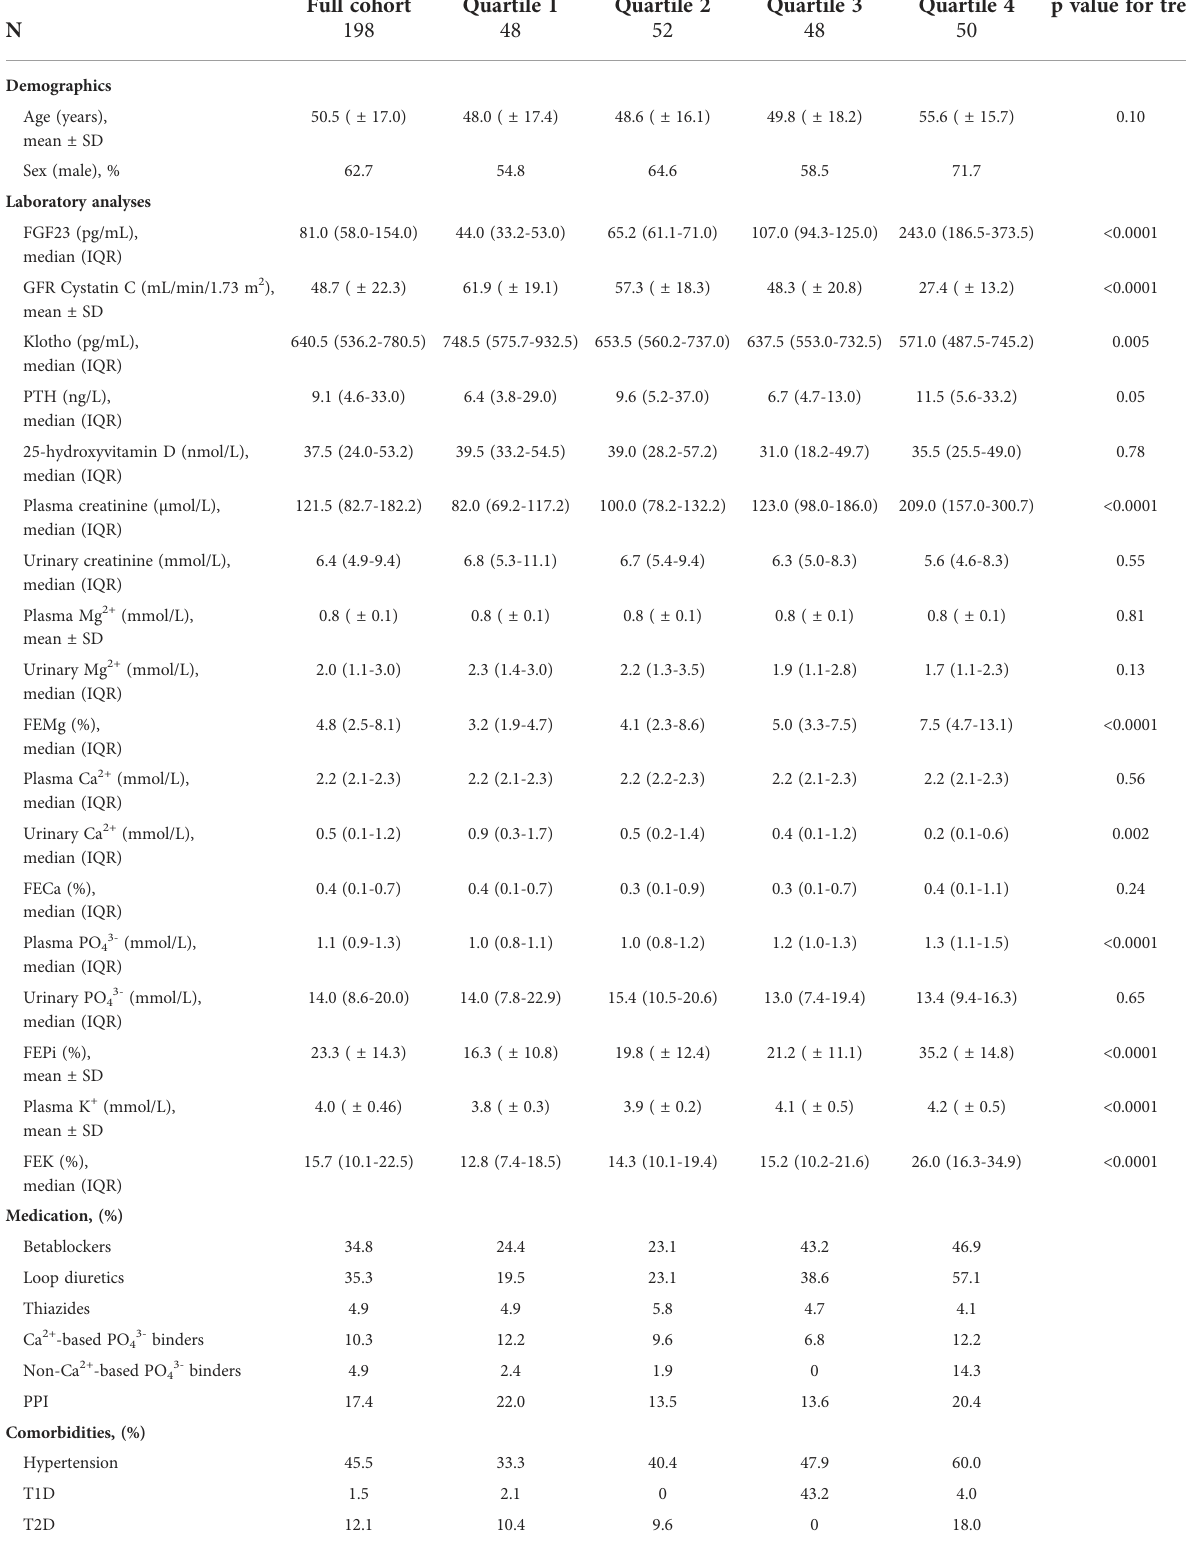
TABLE 1 Baseline characteristics of patients in the CKD cohort (N=198) and of each FGF23